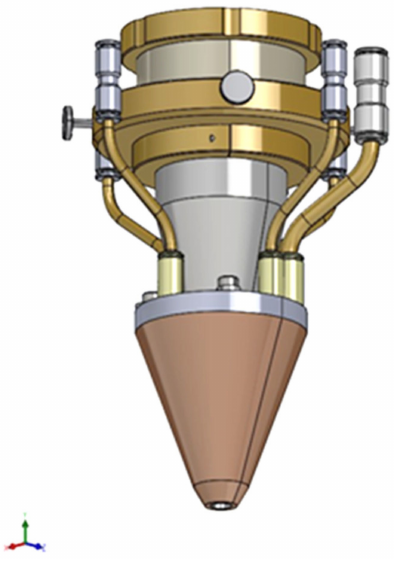
Figure 2. Coaxial configuration for powder feed.